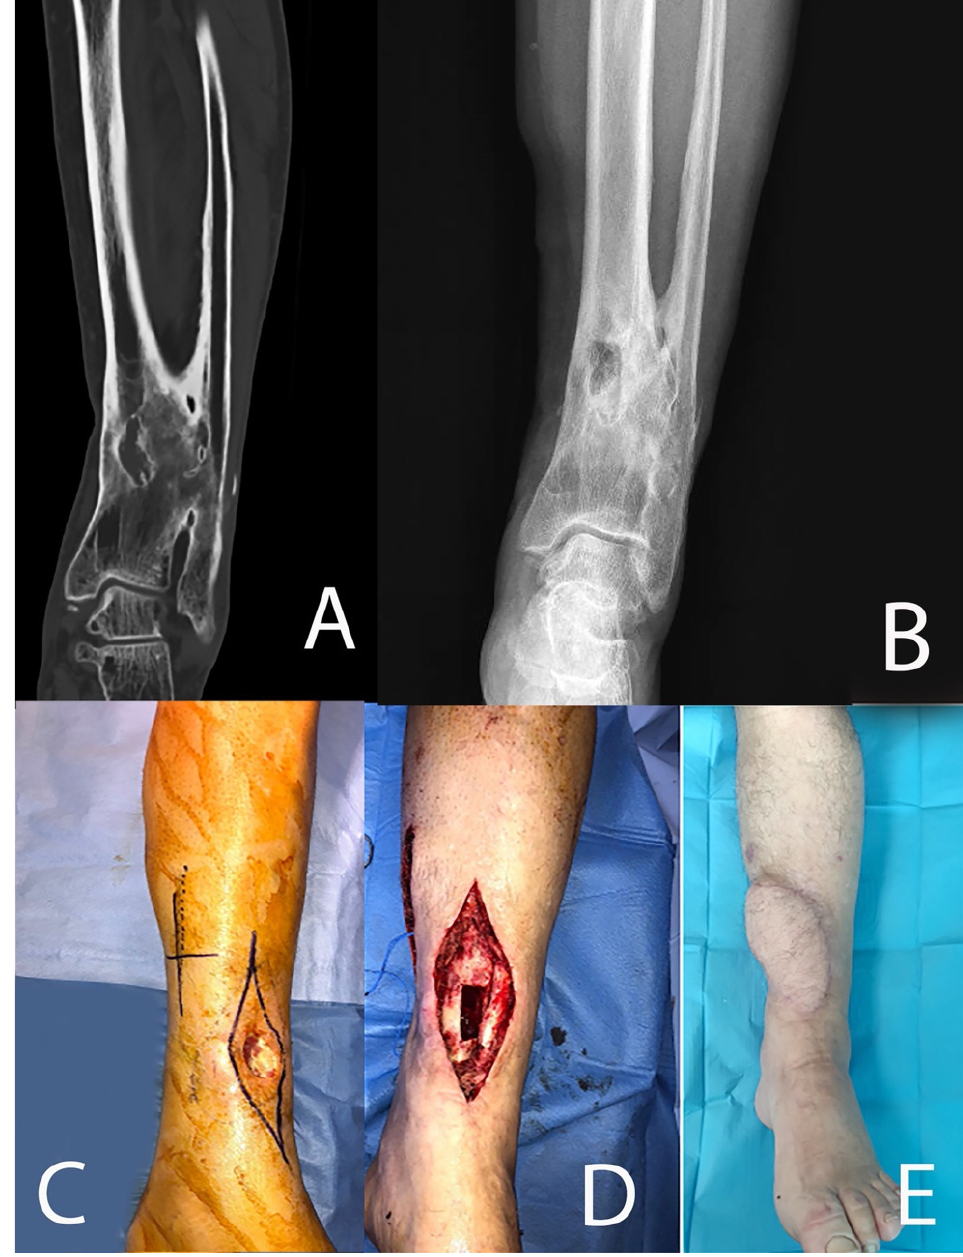
Figure 1. Chronic osteomyelitis of the distal tibia (( A ): pre-operative coronal view CT scan) treated with curettage and antibiotic-loaded beads (( B ): anteroposterior X-rays). The discharging sinus ( C ) was excised together with infected soft tissues ( D ) and reconstructed with a free flap (( E ): 4 months follow-up).